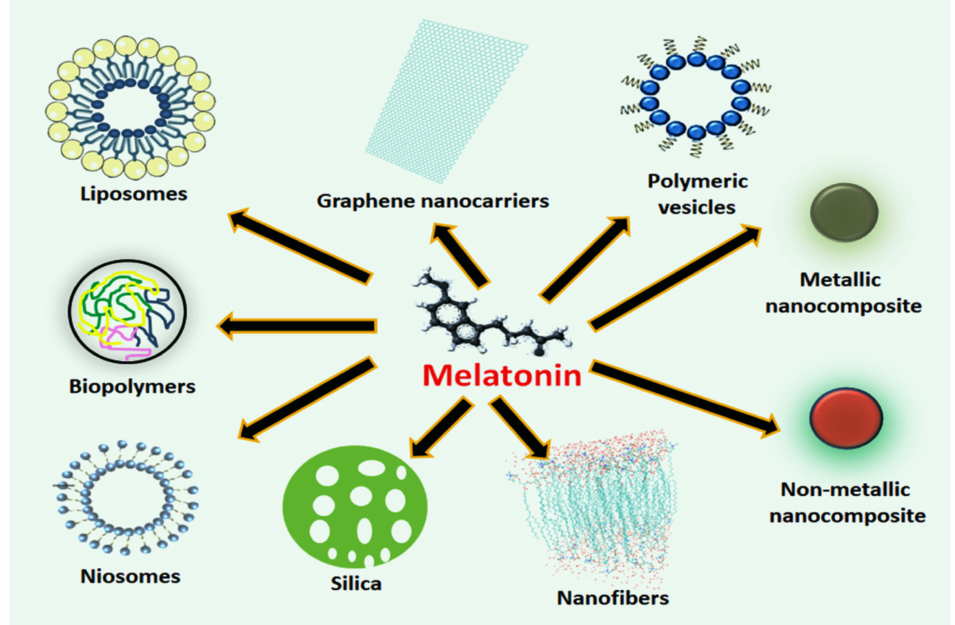
Figure 1. The use of melatonin-loaded nanostructures represents a promising therapeutic strategy. After being incorporated or adsorbed into solid lipidic, biopolymers or polymeric vesicles, silica NPs, nanofibers, graphene nanocarriers, and metallic or non-metallic NPs, melatonin is thought to achieve superior biological effects due to molecular protection and sustained release. These drug-delivery systems may be considered as an important approach to facilitate the permeability of the chemical agent while maintaining systemic safety during the treatment of complex pathologies and disease